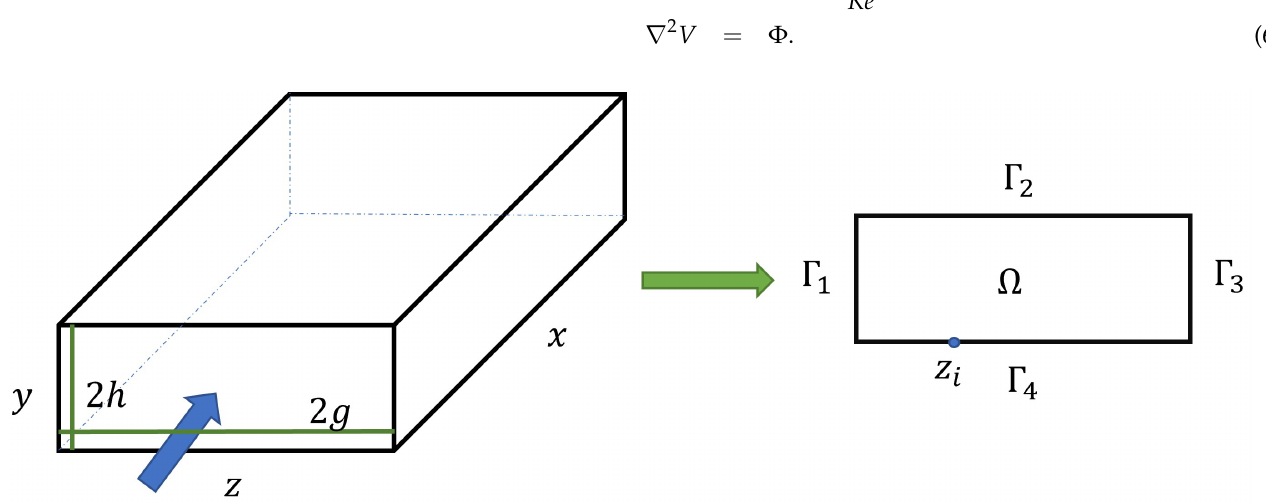
Figure 1. ( Left ) Sketch of a square duct, and ( Right ) details of the two-dimensional